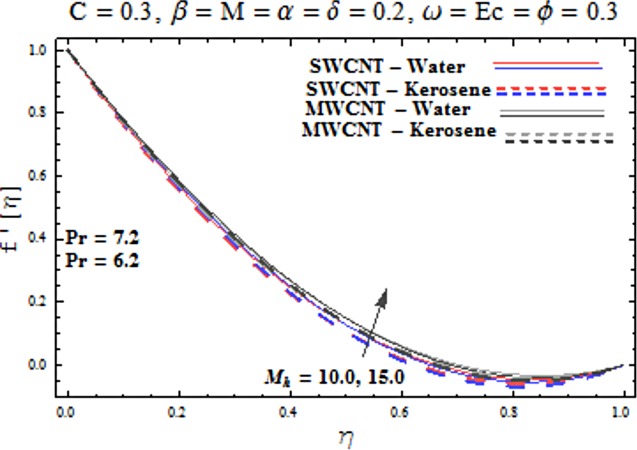
Effect of Mh on f′.